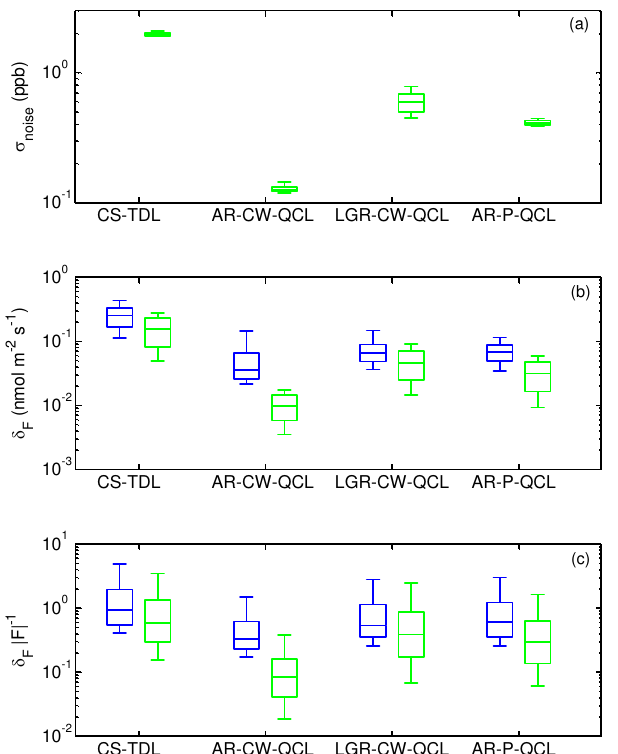
Figure 6. (a) Instrumental noise, presented as 1 standard deviation of the noise at 10Hz frequency, (b) N 2 O flux random error (blue) and flux random error due to instrumental noise (green) statistics; (c) the same as (b) but for relative fluxes. The boxplots present the lower and upper percentiles, quartiles and median values of the distributions. Based on flux measurements during the period DOY 206–271 (period II).